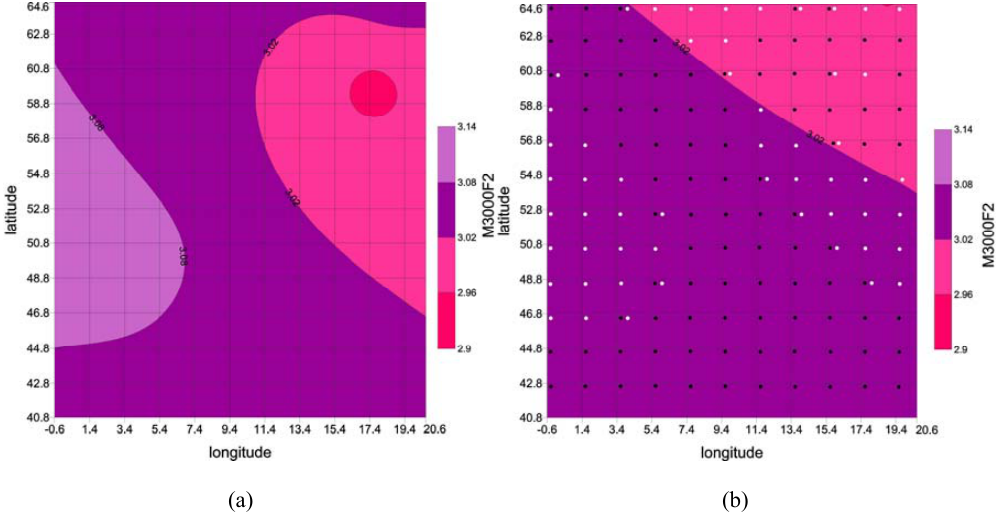
Fig. 7. Same as Fig. 5 but for a short-term forecasting of M3000F2 generated two hours in advance on 4 February 1992 at 17:00UT under very disturbed geomagnetic activity (ap( τ = 0 . 8 ) = 35 . 4; ap( τ = 0 . 9 ) = 41 . 2) using the 8 forecasting local models simultaneously operative for the month of February (see Table